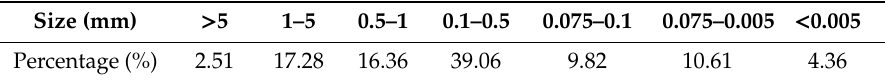
Table 1. Particle size distribution of undisturbed rare earth sample.